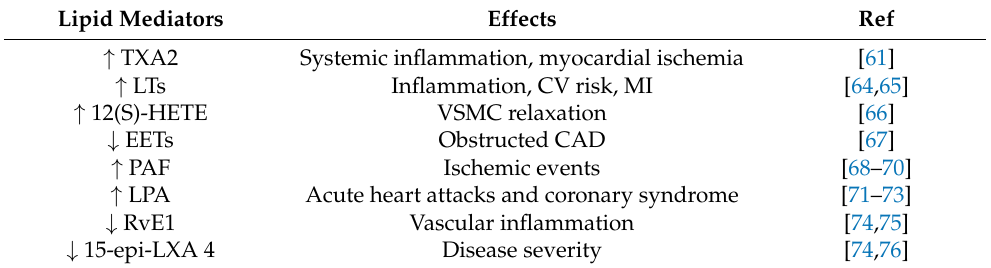
Table 2. Studies of Class 1,2,3 lipid mediators in